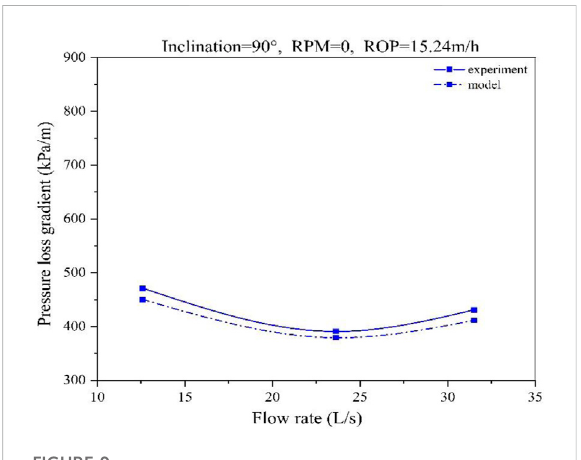
FIGURE 9 Pressure loss gradient at 90 ° , 15.24 m/h, and 0